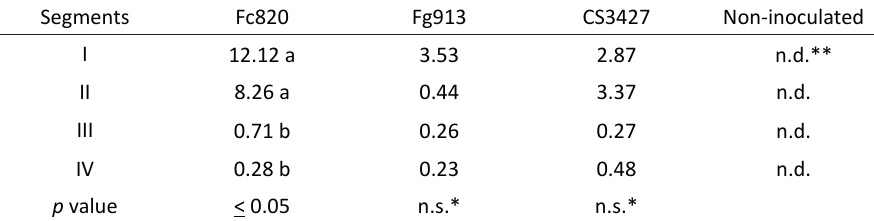
Table 3. Amount of deoxynivalenol (mg kg -1 ), in the samples from different barley segments following stem-base inoculation with F. culmorum (Fc820), F. graminearum (Fg913) and F. pseudograminearum (CS3427) and non-inoculated plants. p values indicate ANOVA test significance if p ≤0.05, letters (a,b,c) indicate significant differences between treatments following the post hoc Tukey HSD